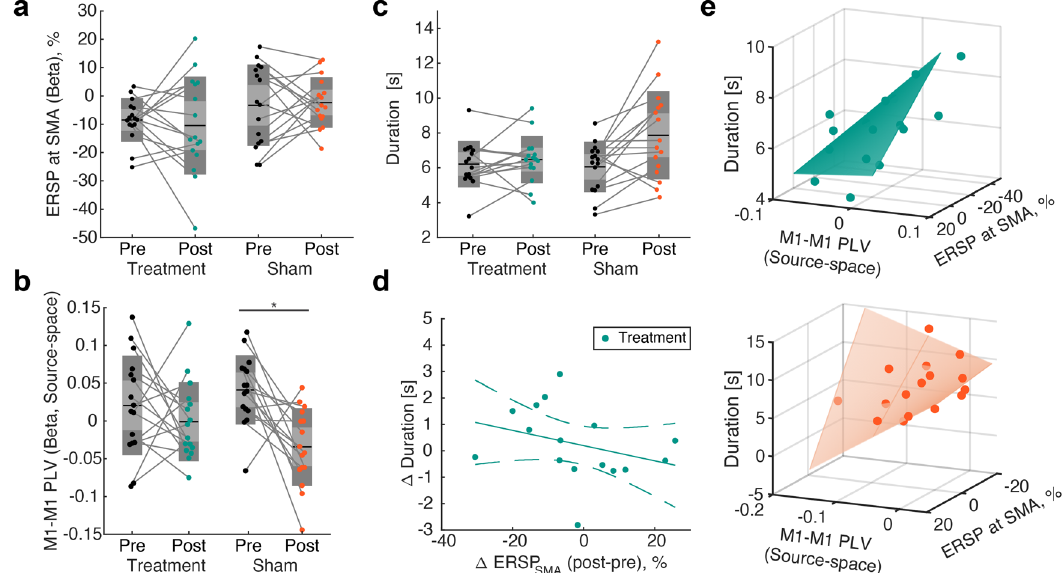
Fig. 4 Treatment effects of repetitive transcranial magnetic stimulation (rTMS). a ERSP magnitude at SMA in the beta-band at pre- and post-evaluation of anti-phase bimanual coordination. A mixed two-way repeated measures ANOVA did not exhibit any signi fi cant interaction or main effect (statistical values in the main text). b Pre-movement M1-M1 PLVs in the beta-band. Differences in phase shuf fl ed data were subjected to a mixed two-way repeated measures ANOVA. A signi fi cant interaction of “ Time ” × ” Group ” was observed ( p = 0.035, statistical values in the main text). A signi fi cant difference in the sham group revealed by post hoc t -tests (*: p < 0.05, statistical values in the main text). c Duration of anti-phase bimanual tapping in pre- and post- evaluation sessions. A mixed two-way repeated measures ANOVA revealed signi fi cant interaction of “ Time ” × “ Group ” effect ( p = 0.029), and post hoc t - test indicated signi fi cant difference in the sham group (*: p < 0.05, statistical values in the main text). d Correlation analysis of changes in duration and SMA-ERSP magnitude in the beta band in the treatment group. Spearman ’ s rank correlation test revealed signi fi cant correlation ( ρ = − 0.54, p = 0.033). Solid and dotted lines indicate linear regression and a 95% con fi dence interval, respectively. e Linear-mixed model for the performance and pre-movement cortical activity patterns in beta-band. In line with the data from experiment 1 (Fig. 3), a signi fi cant main effect was observed for M1-M1 PLV and ERSP magnitude at SMA, and their interaction revealed signi fi cant interaction of SMA-ERSP × M1-M1 PLV effect only in sham treatment group (treatment: ERSP: p = 0.01, PLV: p < 0.001, ERSP× PLV: p = 0.72; Sham: ERSP: p = 0.038, PLV: p = 0.04, ERSP × PLV: p = 0.03). The green and orange curved surfaces represent regression model derived from the treatment and sham groups,